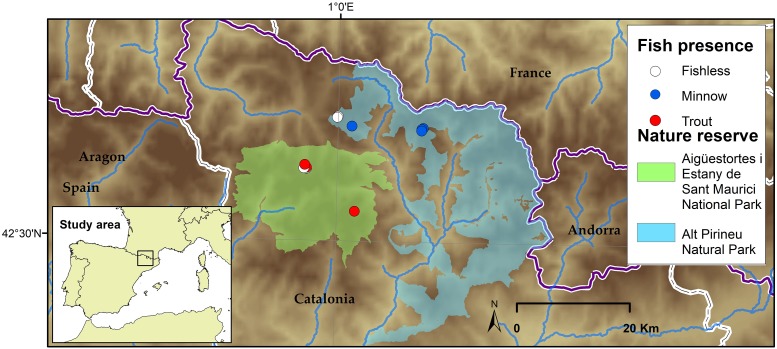
Study site map including the lakes sampled in the Central and Eastern Pyrenees. White color refers to fishless lakes, red as for lakes invaded with trout, and blue as for lakes invaded by dense minnow populations.